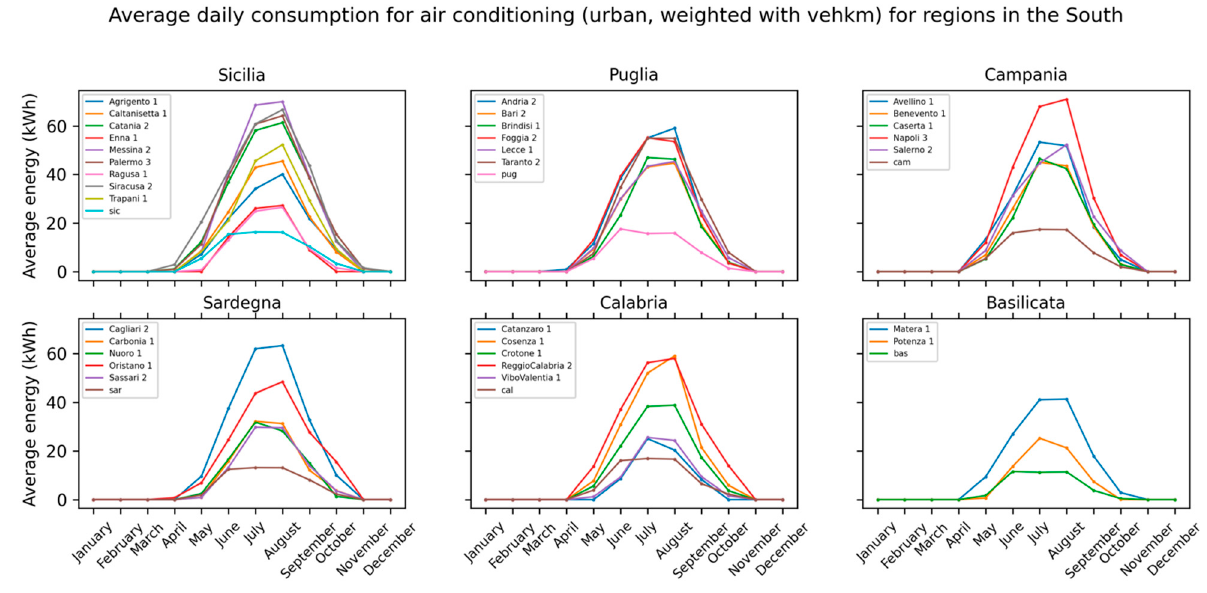
Figure 9. As Figure 7 for Southern Italian Regions.